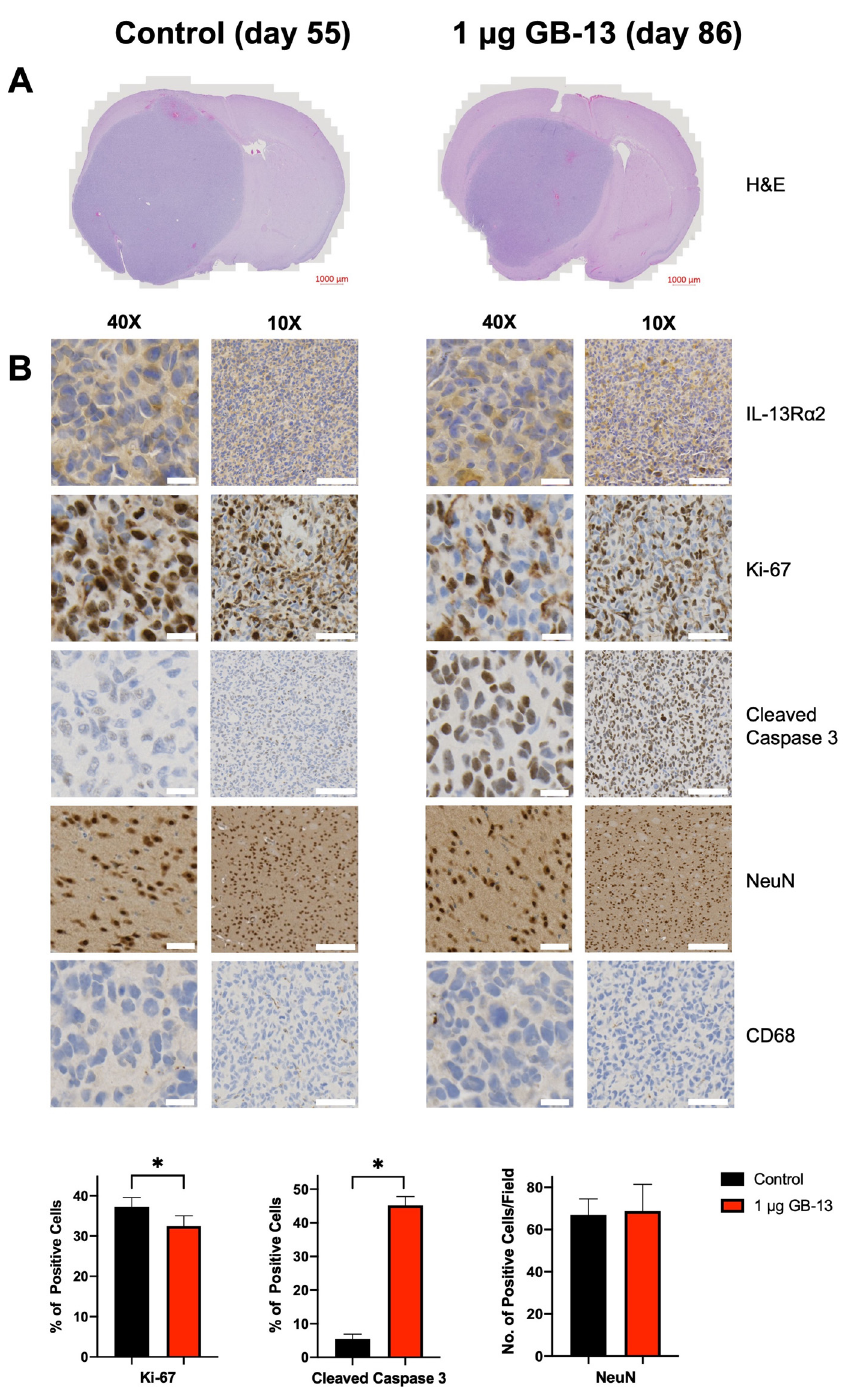
Figure 4. Immunohistochemistry of HGG-bearing mouse brains harvested when moribund. Pre- sented samples were harvested on days 55 and 86 following CED of vehicle solution or GB-13 at a dose of 1 µ g, respectively. Images are representative of four mice in each group. ( A ) Corresponding H&E demonstrates maintained tissue architecture and decreased tumor size after GB-13 treatment. ( B ) While IL-13R α 2 status is retained after a single CED infusion of GB-13, treatment leads to de- creased cell proliferation ( p = 0.03) and increases the number of apoptotic cells ( p < 0.0001). The density of NeuN-positive neuronal (NeuN+) cells is retained in ipsilateral brain regions ( p = 0.82). CD68+ monocyte infiltrate is not evidenced following GB-13 exposure. Scale bars: 40×: 20 μ m, 10×: 100 μ m.